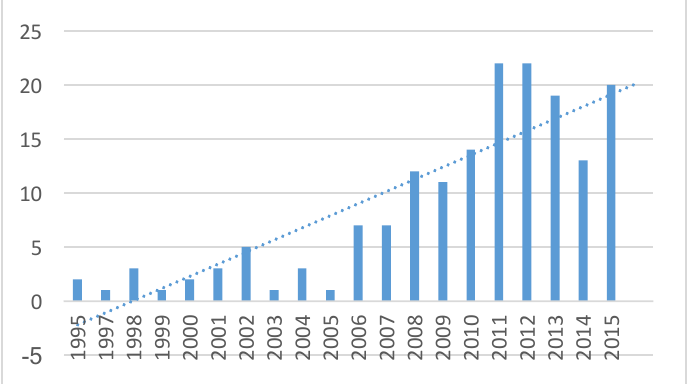
Fig. 4. FEI works from 1995 to